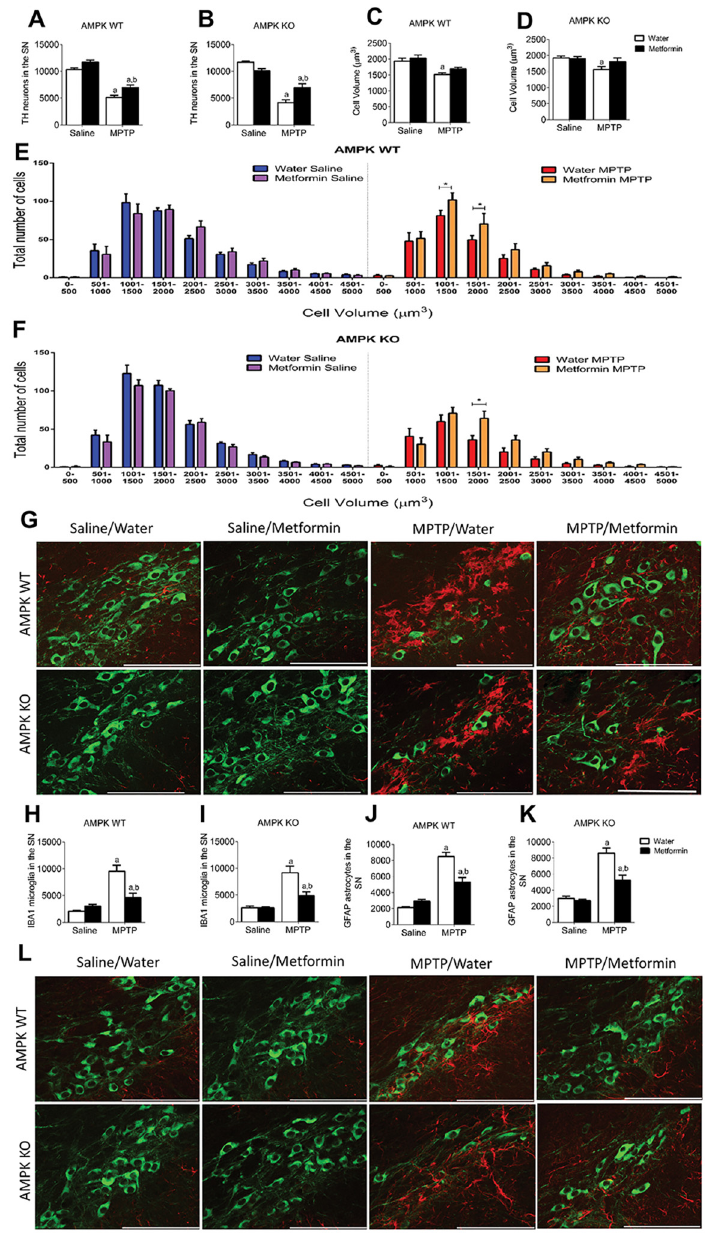
Fig 3. Metformin preserves cell number and volume after MPTP exposure, independent of genotype. Stereological quantification of TH levels in the SN shows a protective effect of Metformin after MPTP exposure in both AMPK WT ( A ) and KO ( B ) mice. Overall cell volume shows a significant reduction after MPTP exposure in water treatment but not with Metformin treatment in AMPK WT ( C ) and KO ( D ). When TH cells were separated and plotted based on volume distribution, mice treated with MPTP and Metformin had a significant effect on smaller volume (1000 – 2000 μ m 3 ) cells compared to those not treated with Metformin in both AMPK WT ( E ) and KO ( F ) mice. G , Representative image showing MPTP induced microglial activation in the SN (green = TH, red = IBA1). Stereological quantification of IBA1 ( H & I ) and GFAP ( J & K ) showing increased numbers after MPTP with a significant protective effect of Metformin in both AMPK WT and KO. L , Representative images showing MPTP induced astrocytic activation in the SN (green = TH and red = GFAP). a, significant compared to Water/saline treated mice and b, significant compared to Water/MPTP treated mice. * = p < 0.05. Data are represented as mean ± SEM (n = 7 – 10, two-way ANOVA, p < 0.05).